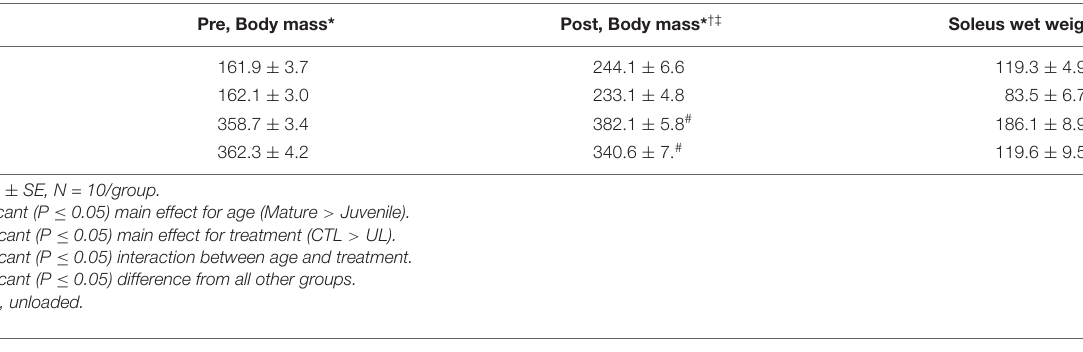
TABLE 2 | Effects of age (mature/juvenile) and treatment (control/unloaded) on peak tension ( N ) at beginning (Initial) and conclusion (Final) of 5 min train of indirect (nerve) or direct (muscle)